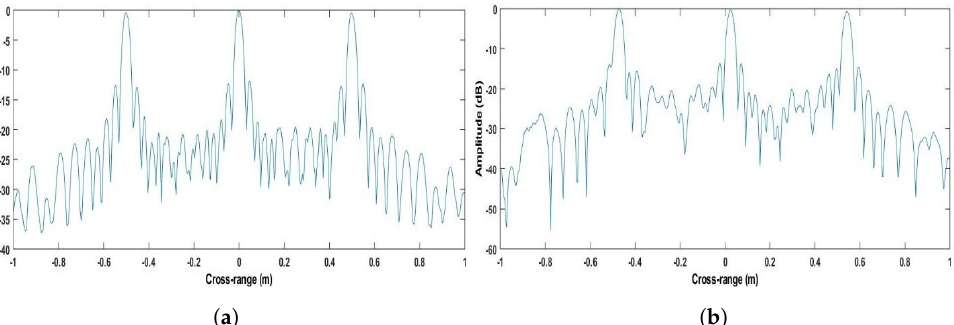
Figure 12. Cross-section of Stripmap SAR in the cross-range dimension for ( a ) simulation and ( b )